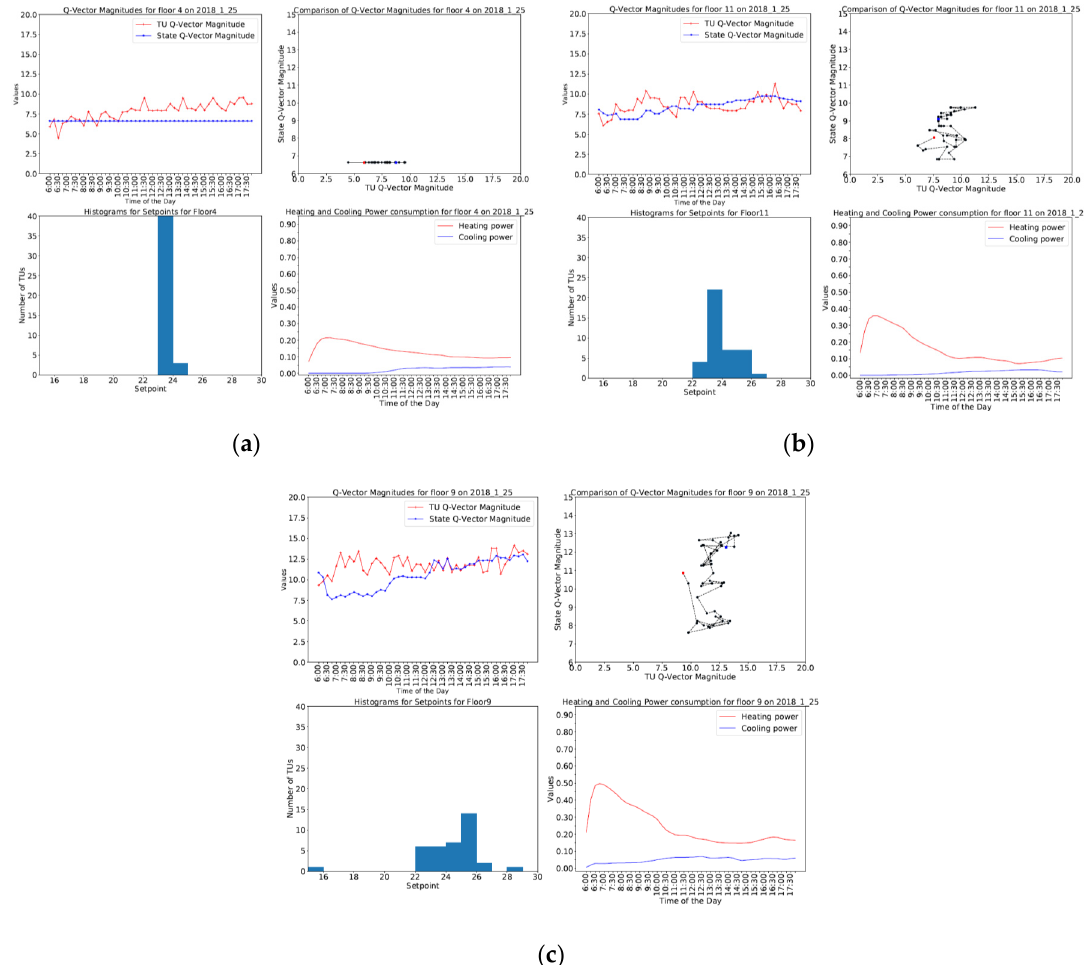
Figure 12. Graphs depicting the variation of TU Q-vector magnitudes and state Q-vector magnitudes, Scatterplot of TU and state Q-vector magnitudes, Set point histogram, Heating and cooling power consumption for different behaviors on ( a ) Floor 4 ( b ) Floor 11 ( c ) Floor 9 on 2018.1.25 (winter day).